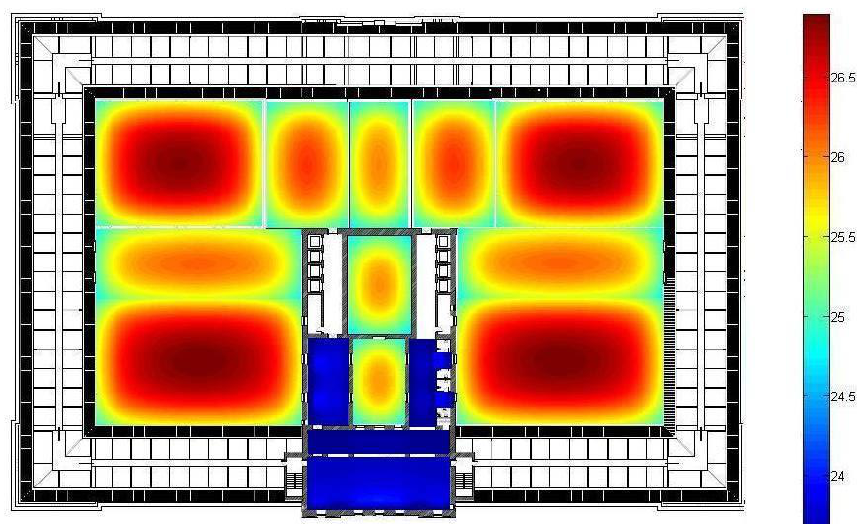
Figure 19. Temperature distribution in deg. C, during winter, inside the retrofitted spaces.